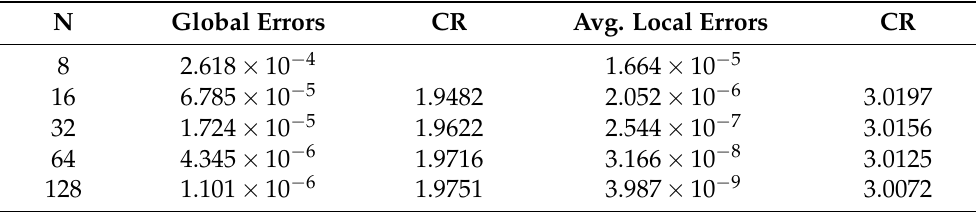
Figure 2. ( Left ) The global convergence rates and average local convergence rate for Example 4 with both referenced slope of 2 and 3; and ( Right ) the mean-square convergence stability of the schemes with ∆ t = 1/8, ∆ t = 1/16, and ∆ t = 1/32. Table 1. Errors and convergence rates of Scheme 5 with the parameters of Example 4.